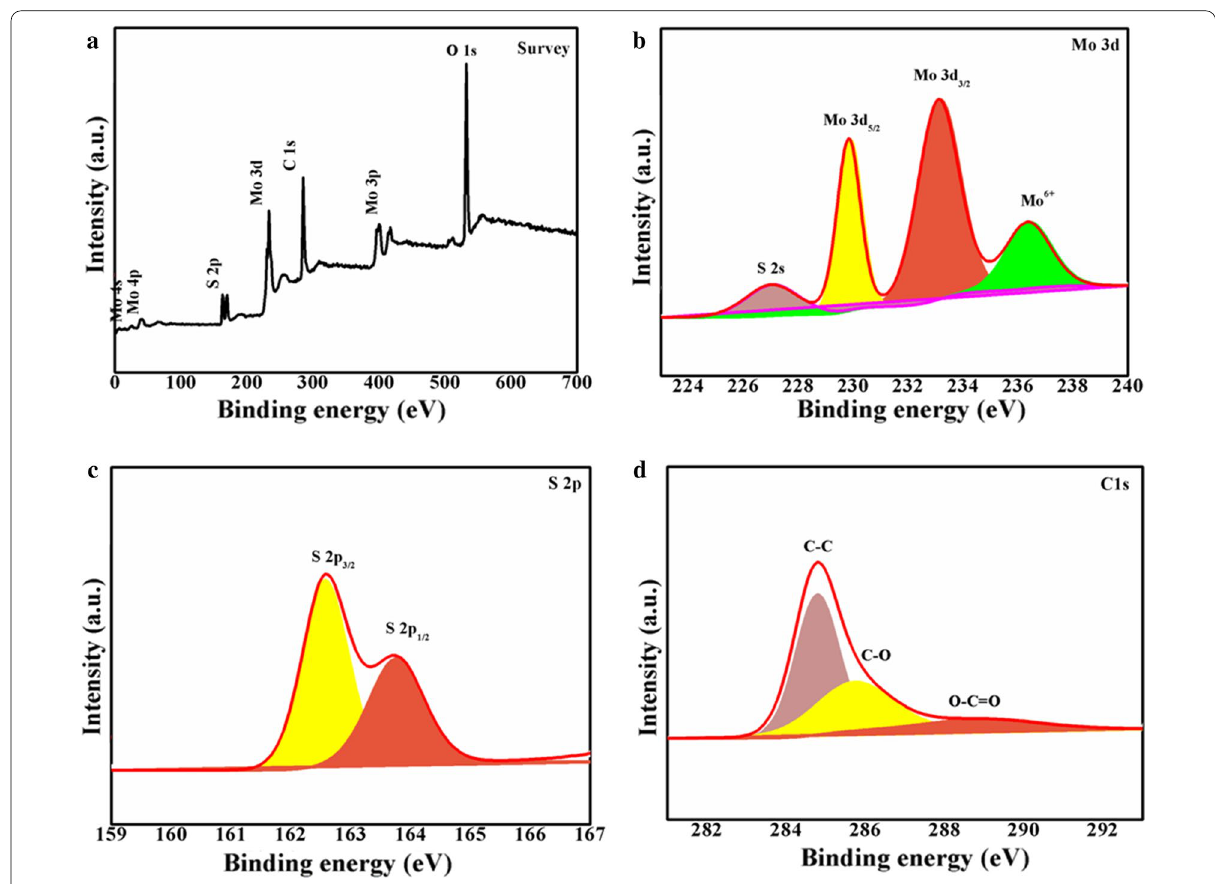
Fig. 3 XPS spectrums of MoS 2 /C nanospheres: a survey, b Mo 3 d , c S 2 p , d C 1